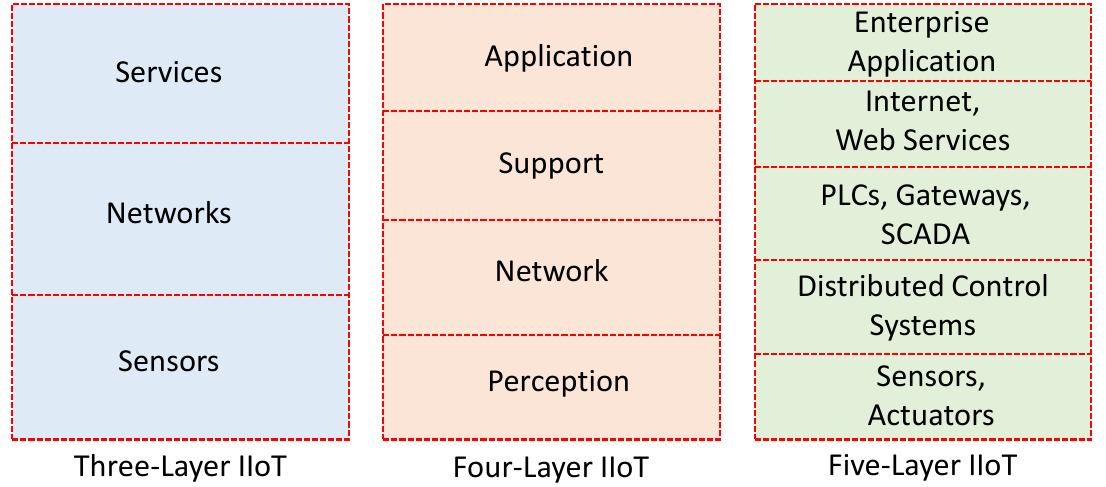
Figure 3. Outline of various available IIoT architectures based on layers (three-layer [5], four-layer [39], and five-layer